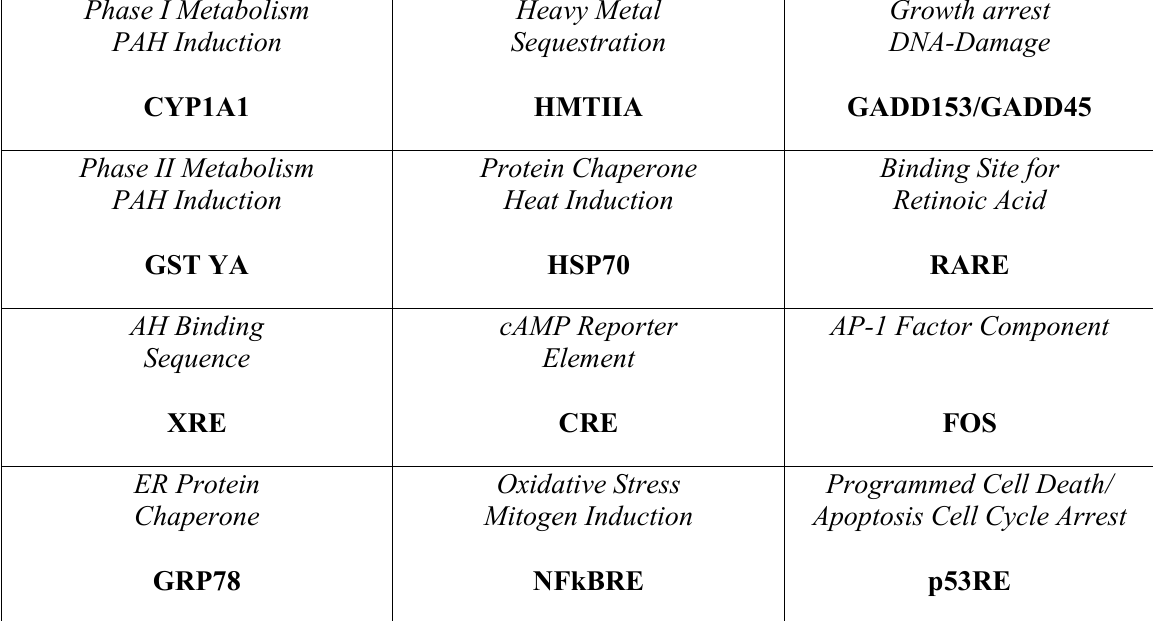
Table 1 . Stress gene promoter/response element—CAT fusion constructs and their biologic